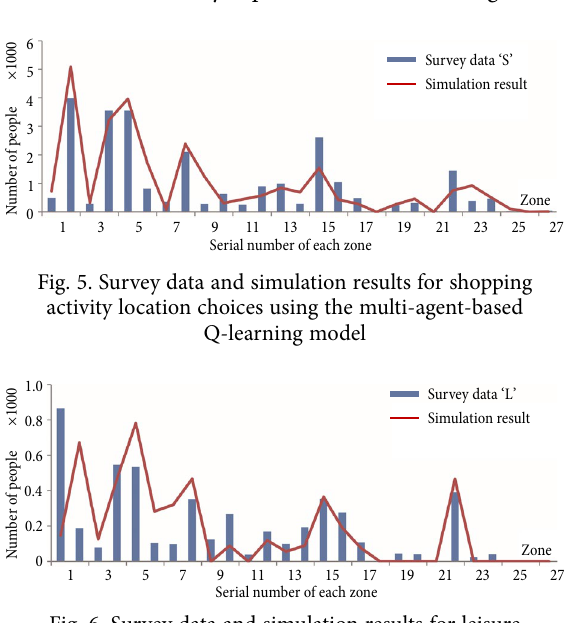
Fig. 6. Survey data and simulation results for leisure activity location choices using the